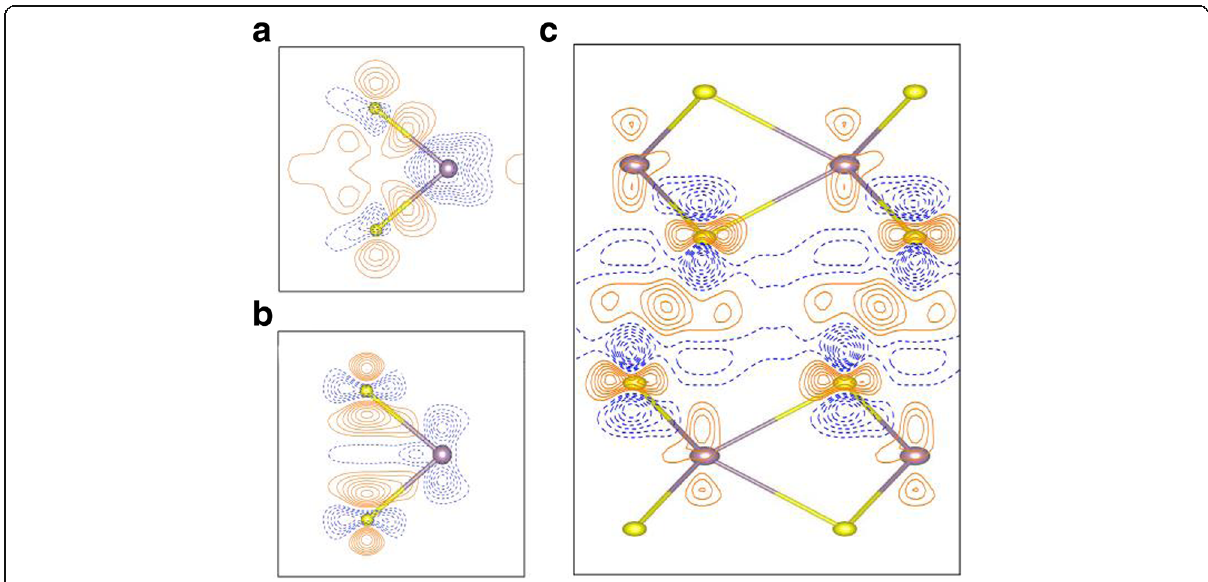
Fig. 5 a Deformation charge density, Δ ρ 1 ( r ) = ρ ( r ) − ∑ μ ρ atom ( r − R μ ), in the monolayer MoS 2 . b Differences between the charge densities of monolayer and the corresponding layer of bulk. c The interlayer charge density redistribution of bilayer MoS 2 . Contour interval of a is 2.5 × 10 − 2 e/Å 3 , while both those of b and c are 2.5 × 10 − 4 e/Å 3 . Solid orange and dashed blue lines correspond to Δ ρ > 0 and Δ ρ < 0 ,